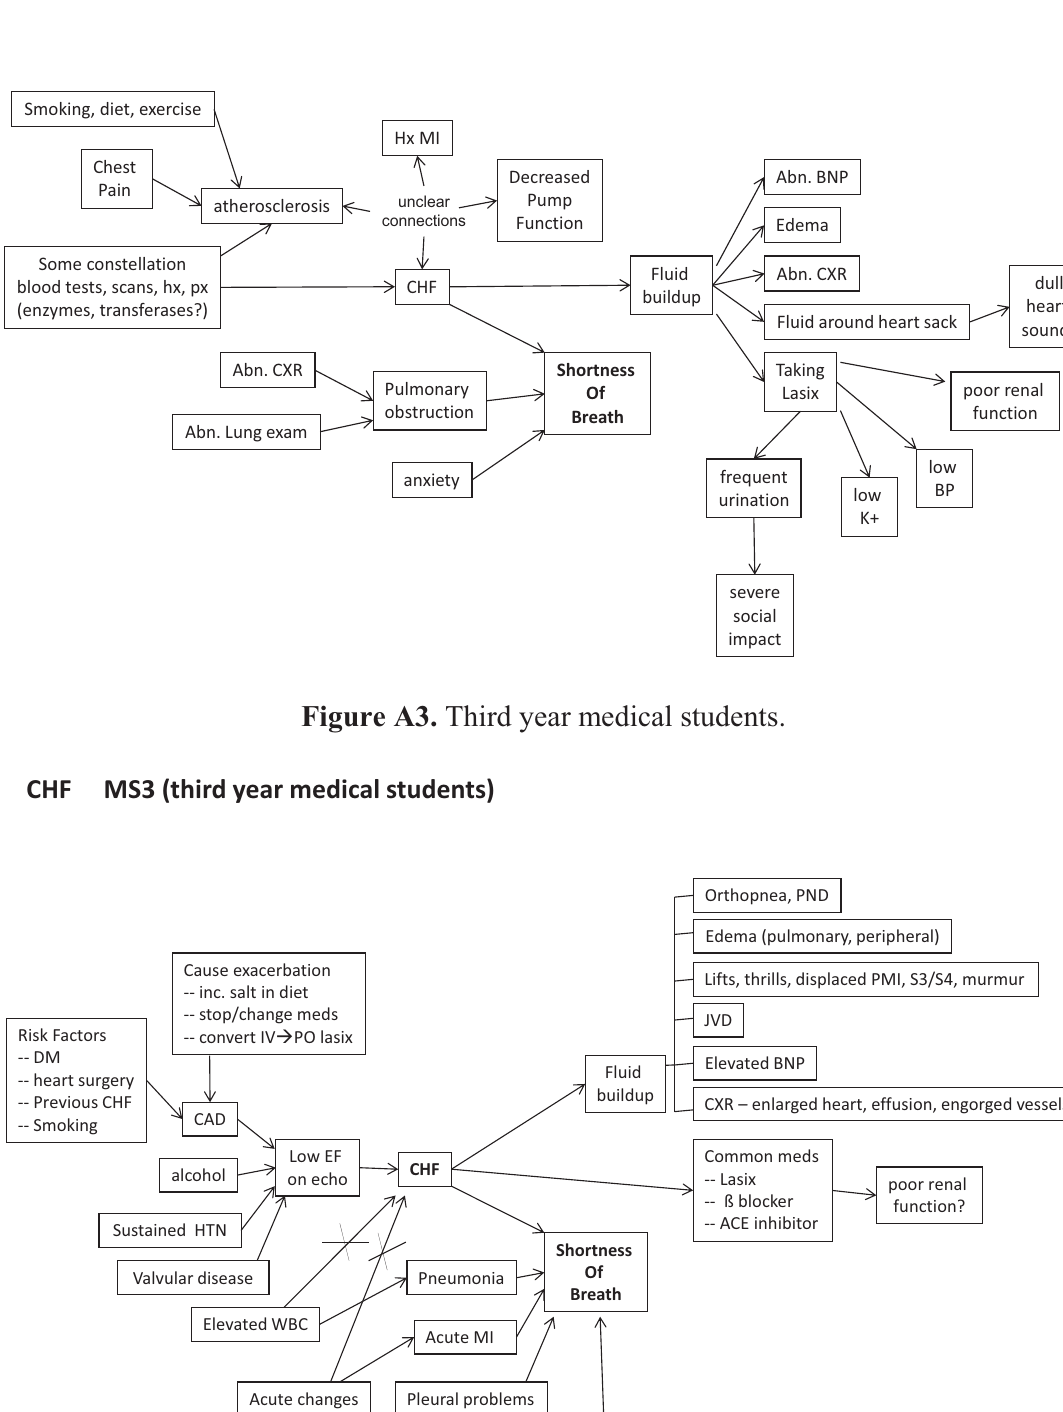
Figure A2. First year medical students.